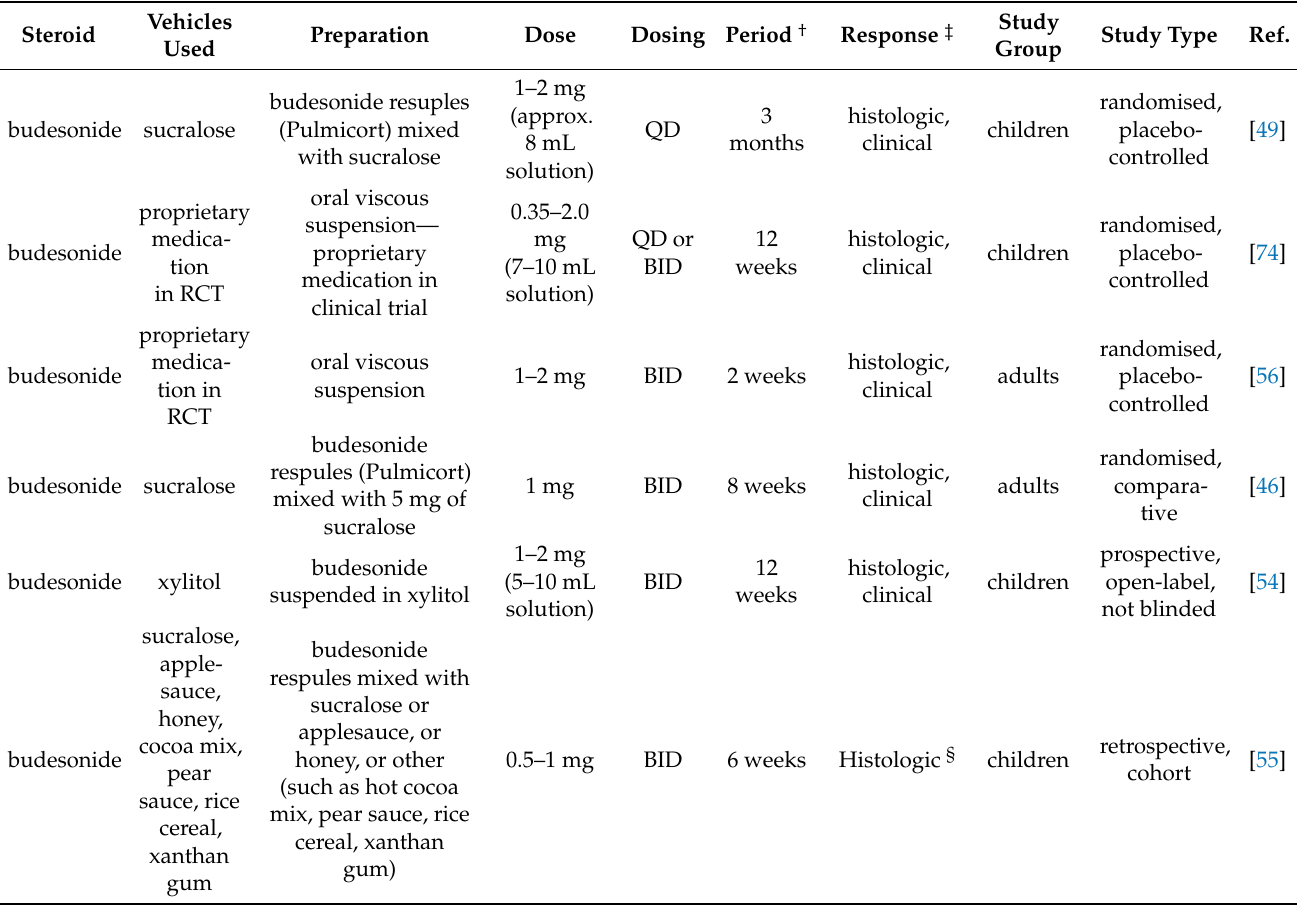
Table 3. Overview of oral viscous suspensions of topical steroids used for EoE in randomised controlled trials (RCT) and other